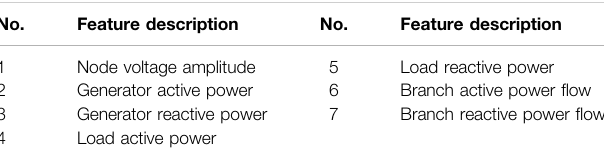
TABLE 1 | Original features of